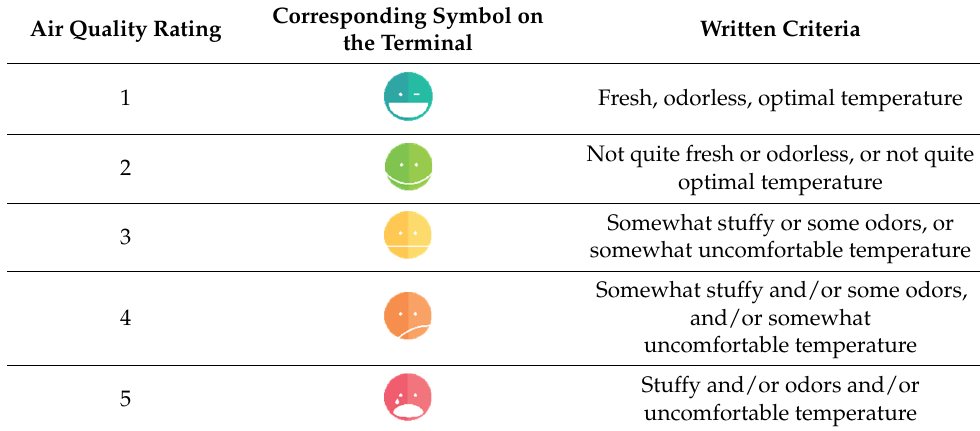
Table 4. Feedback terminal evaluation scale and symbols.